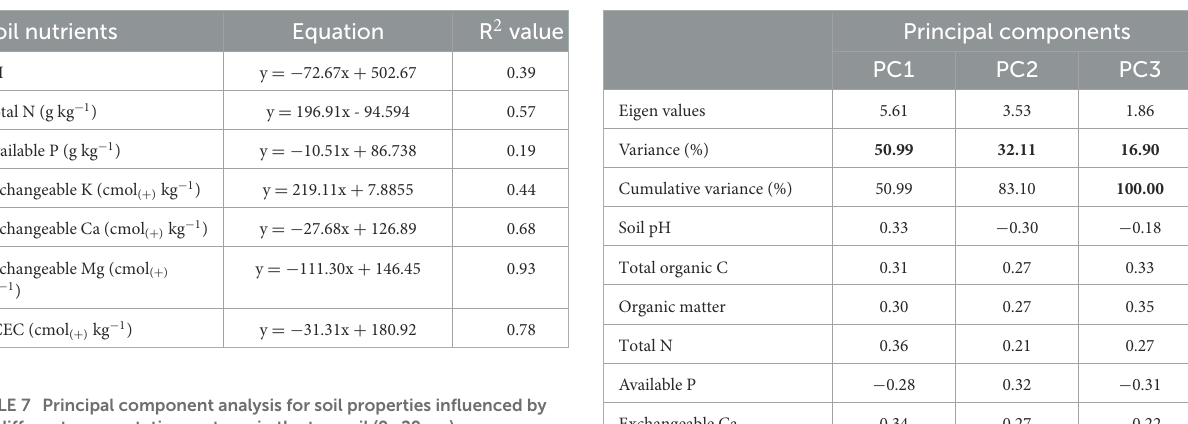
TABLE 8 Principal Component Analysis for soil properties influenced by the different crop-rotation systems in the sub-soil